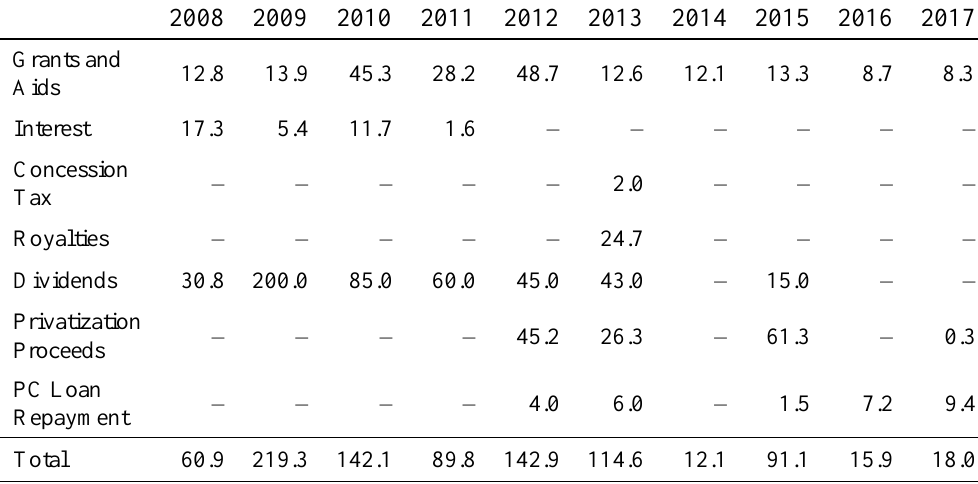
Table 3. Items of Irregular Receipts (millions of